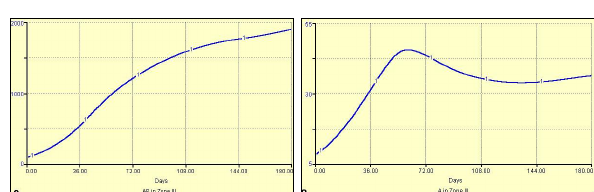
Figure 22. Simulation results of the main ecological indices Fig. 22. Simulation results of the main ecological indexes at zone III for zone 3. (a) Aquatic plant biomass (AP); (b) phytoplankton biomass (A). Fig. 22. Simulation results of the main ecological indexes at zone III